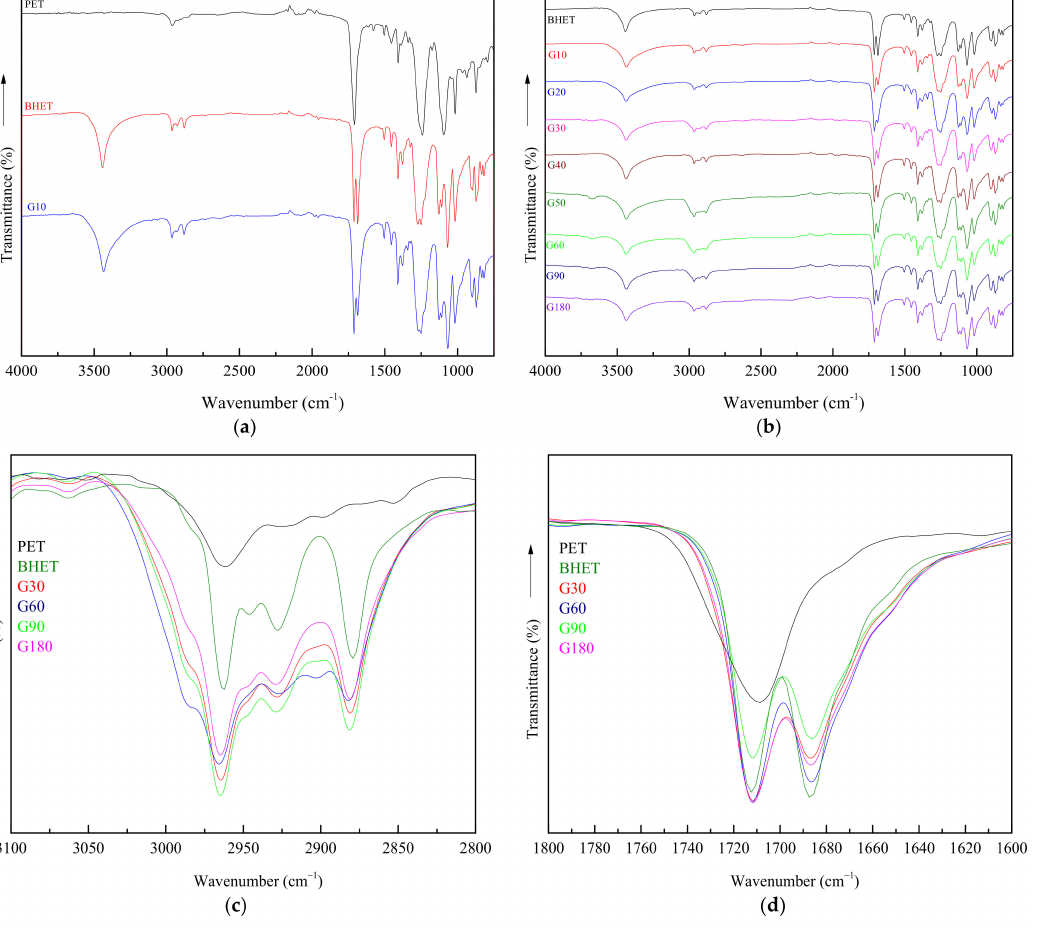
Figure 1. FTIR spectra of PET and reaction products: ( a ) FTIR spectra of reference PET and BHET together with that of the product obtained after 10 min of reaction; ( b ) FTIR spectra of products obtained at different reaction times together with that of the reference BHET; ( c ) Band corresponding to aliphatic groups –CH 2 –, for G products, BHET and PET; ( d ) Band corresponding to ester groups C=O, for G products, BHET and